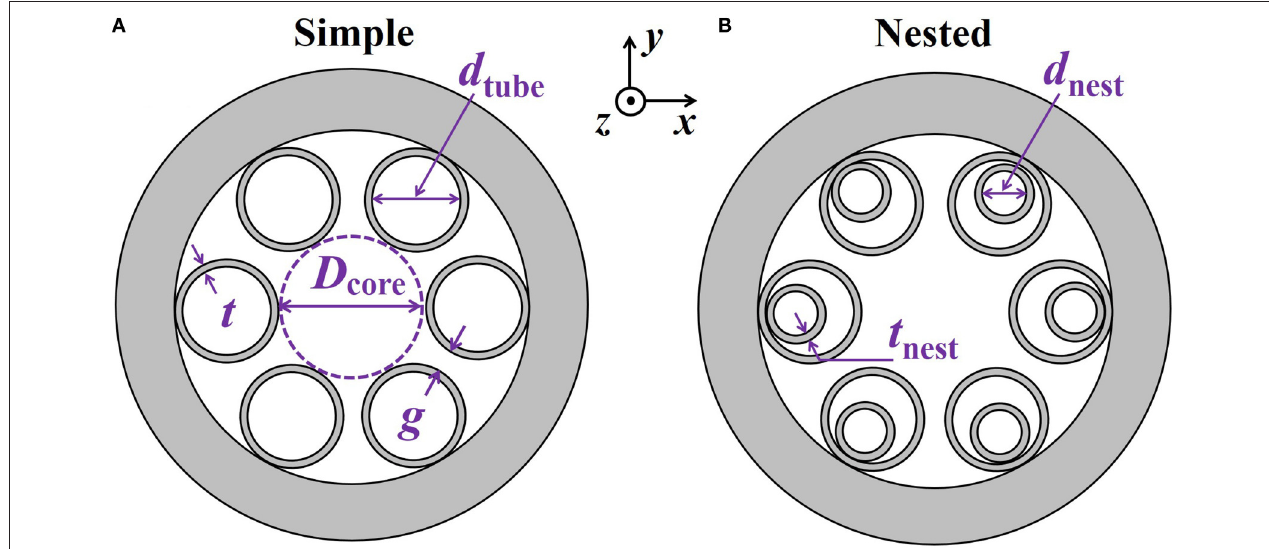
FIGURE 1 | Cross sections of (A) a simple and (B) a nested negative curvature